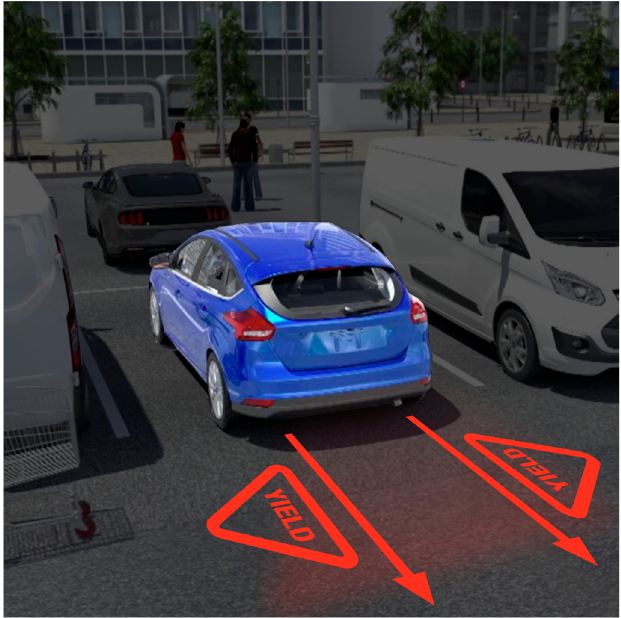
Figure 11. Projected image final design recommendation.